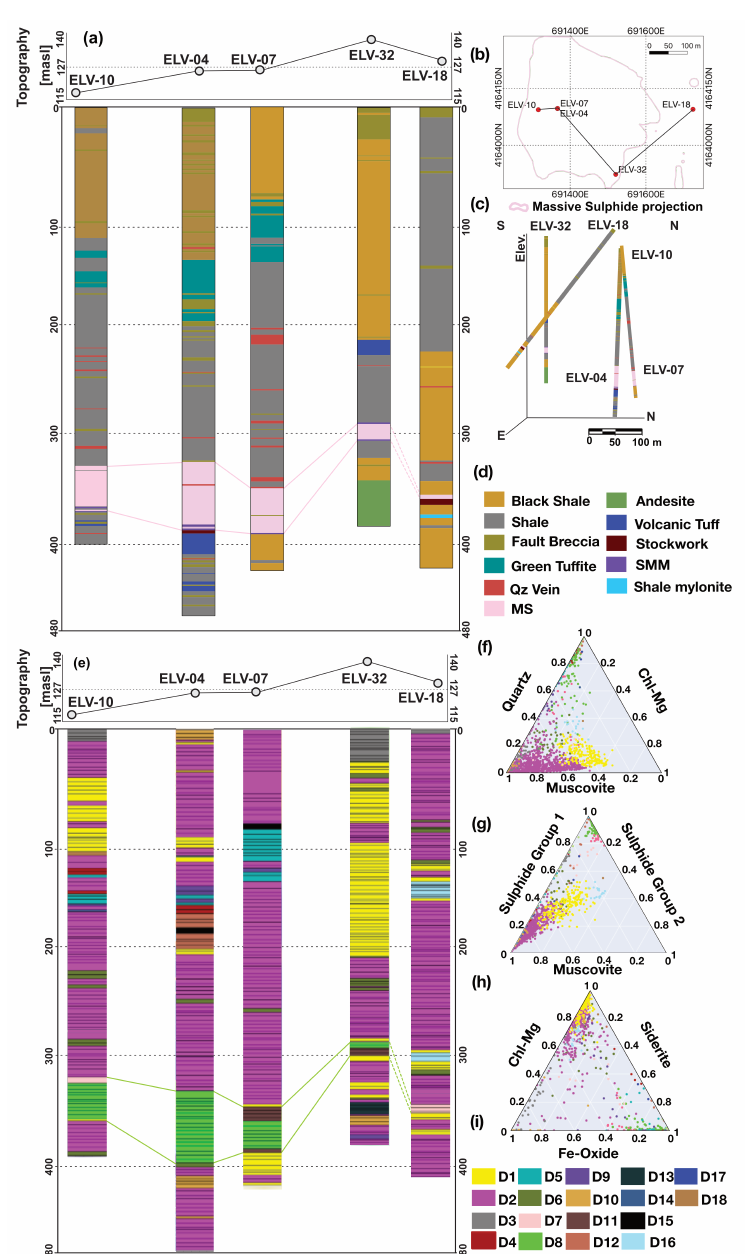
Figure 9. E-W cross-section through the Elvira deposit showing ELV-10, ELV-04, ELV-07, ELV-32, ELV-18 boreholes. On top of the cross-section a topographic profile is shown. Continuous lines extrapolate horizontally the correlation of massive sulfide lithology/domains). ( a ) Boreholes with the color scheme guided by the lithological classification performed by the mine geologists. ( b ) Base map from the Elvira site, showing the cross-section profile and surface projection of the massive sulphide lens. ( c ) 3D visualisation of the boreholes utilized in the profile. ( d ) Lithological color legend. ( e ) Boreholes with the color scheme guided by the geological domains derived from the hyperspectral data by the proposed methodology extracted at a scale of 5. ( f–h )Ternary diagrams showing composition of geological domains. ( i ) Geological domains color